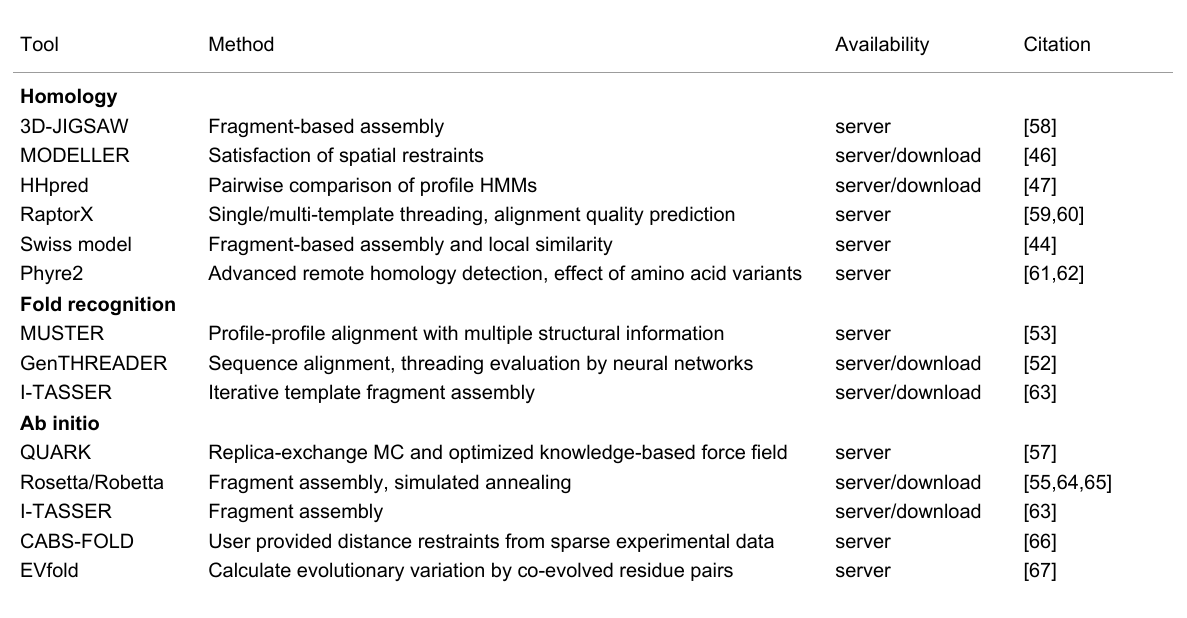
Table 1: Some of the popular structure prediction tools, methods of prediction and their